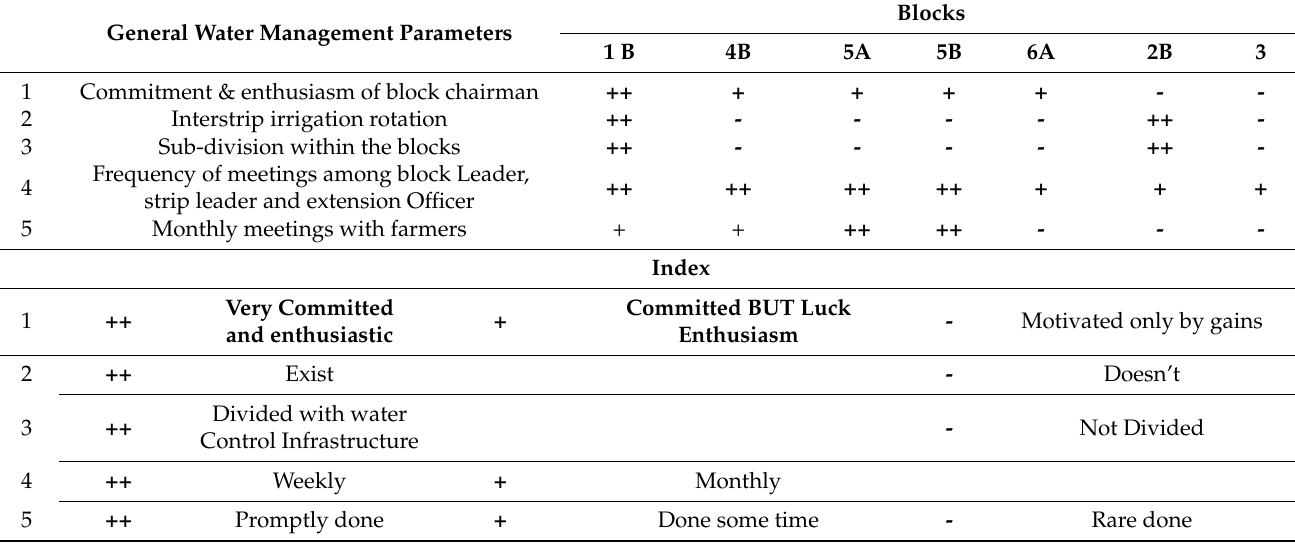
Table 3. Water management parameters within the